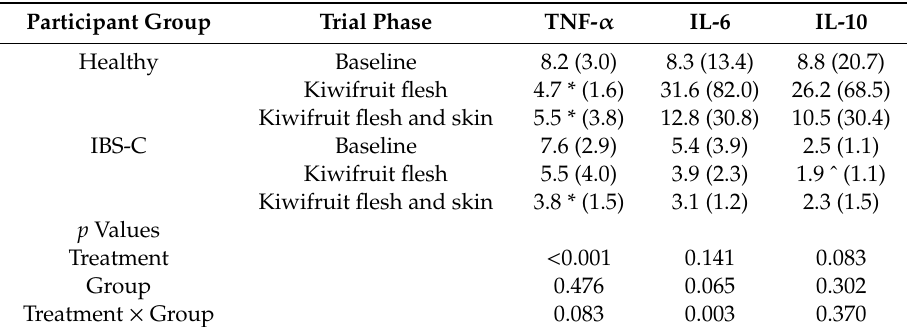
Table 3. Blood cytokine concentrations (pg / mL) of the participants consuming SunGold kiwifruit with and without skin 1